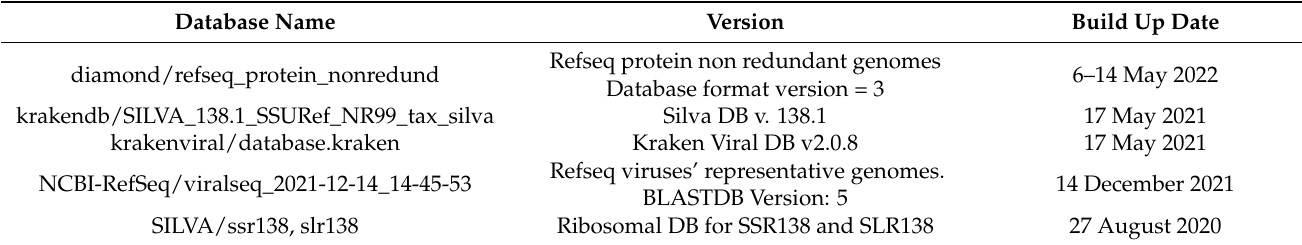
Table 2. Databases used by PIMGAVir and